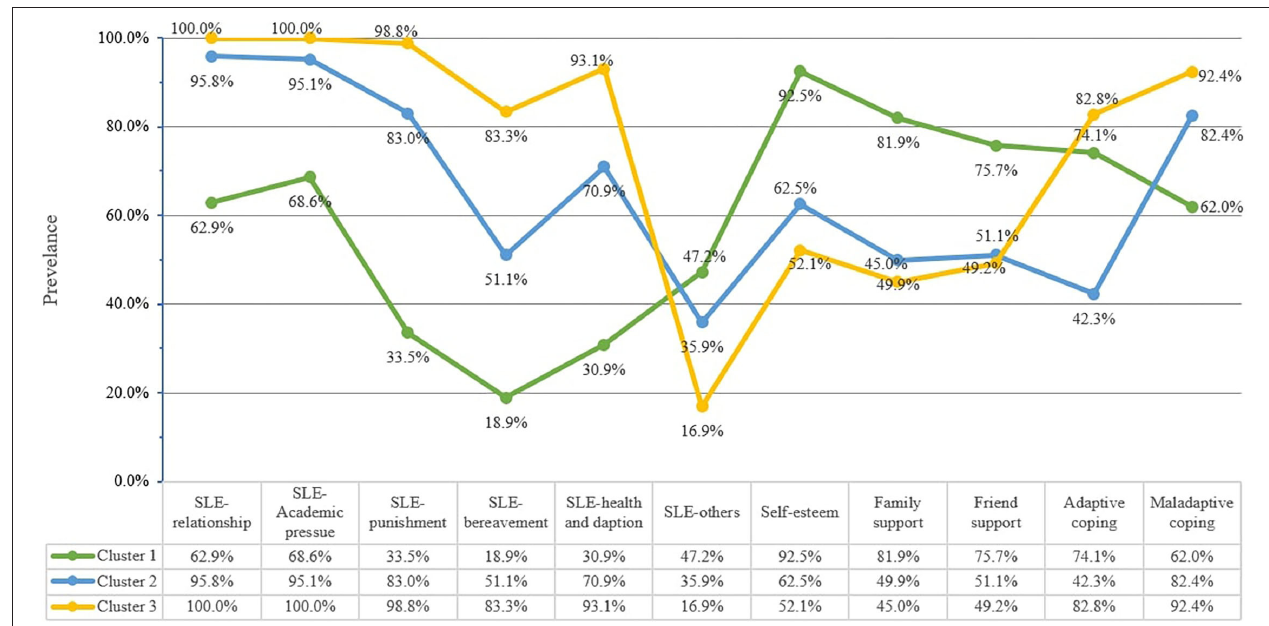
FIGURE 3 | Line-chart displaying the levels of participants’ risk and protective profiles. SLE: stressful life events. The percentage of SLE variables represented the proportion of individuals who had at least one type of stressful life events in the specified domain. The percentage of self-esteem, family support, friend support, adaptive coping and maladaptive coping variables represented the proportion of individuals who scored above the median of the specified